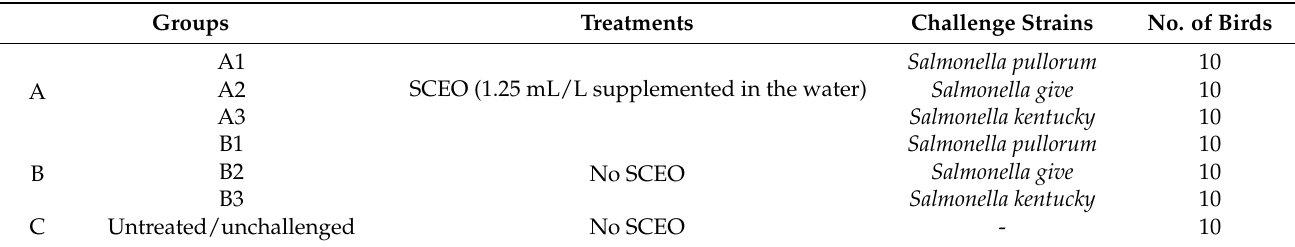
Table 2. Arrangement of laboratory challenge/protection